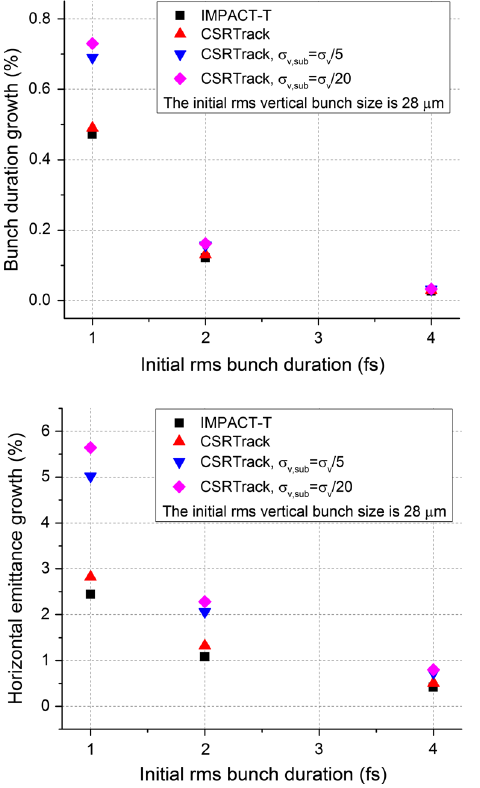
FIG. 3. Same as Fig. 2 but with a reduced initial vertical bunch size of 28 μ